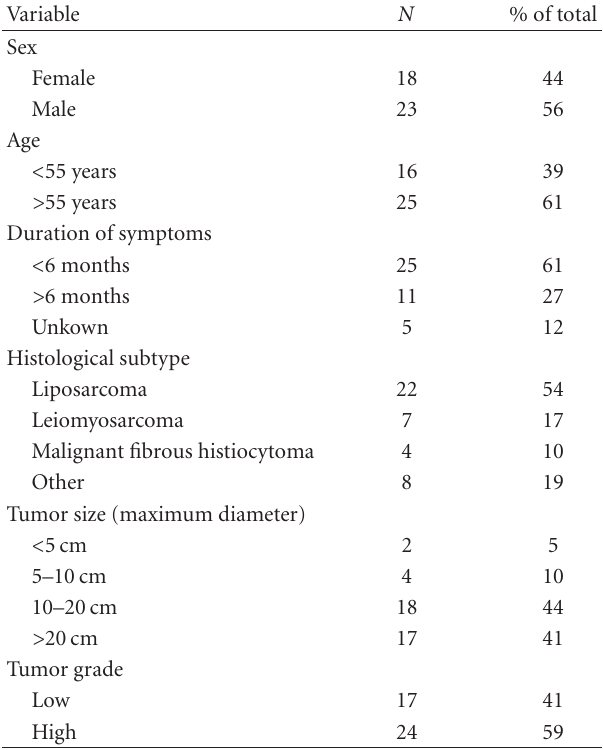
Table 1: Demographic and tumor characteristics of 41 patients with primary retroperitoneal sarcoma who underwent surgical resection at Stanford Hospital from 1996 to